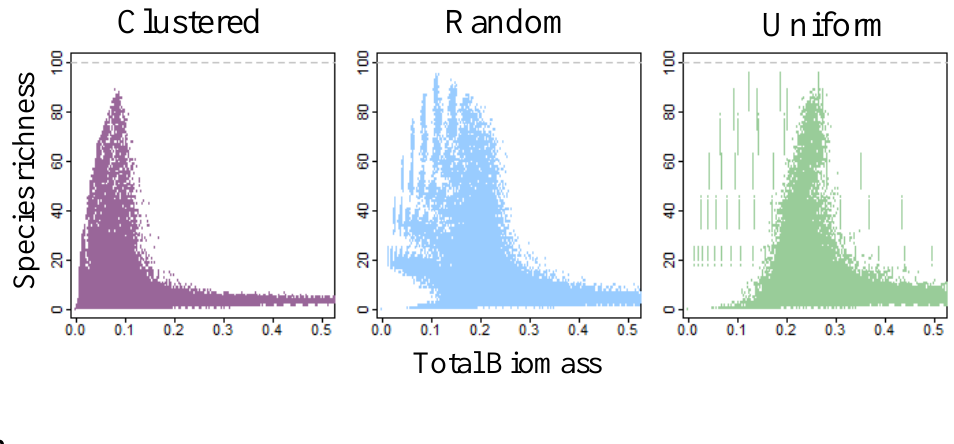
Figure 3. The unaveraged richness-biomass relationship for 200 simulation runs. Each point represents the state of a single community at a point in time. The dotted grey line indicates the size of the species